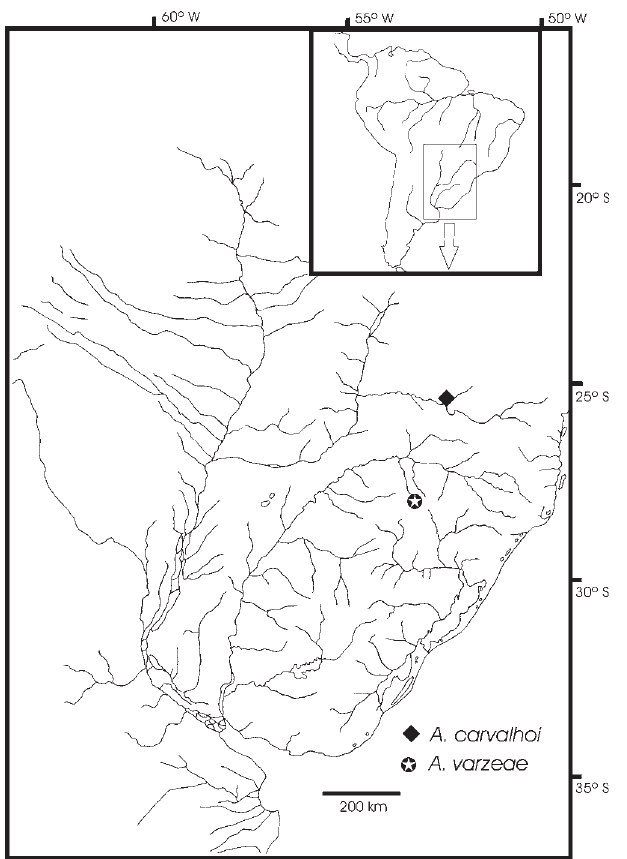
Fig. 2. Geographic distribution of Austrolebias carvalhoi and A. varzeae